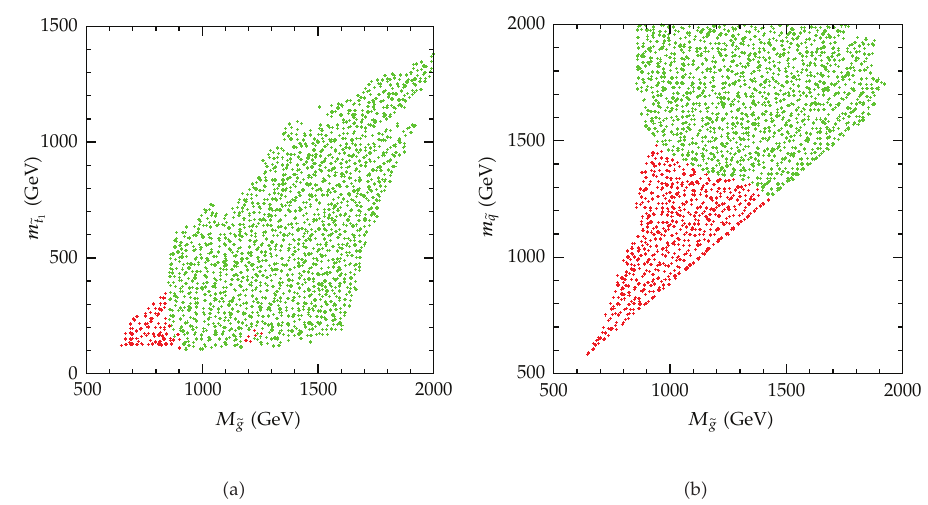
(cid:2) a (cid:3) and m (cid:2) (cid:2) b (cid:3) as a function of M (cid:2) (cid:2) darker points (cid:3) satisfy the weaker bounds Figure 4: m (cid:2) q g . Points in red t 1 (cid:2) 2.12 (cid:3) , but not the stronger bounds (cid:2) 2.13 (cid:3) , while points in green (cid:2) brighter (cid:3) satisfy both